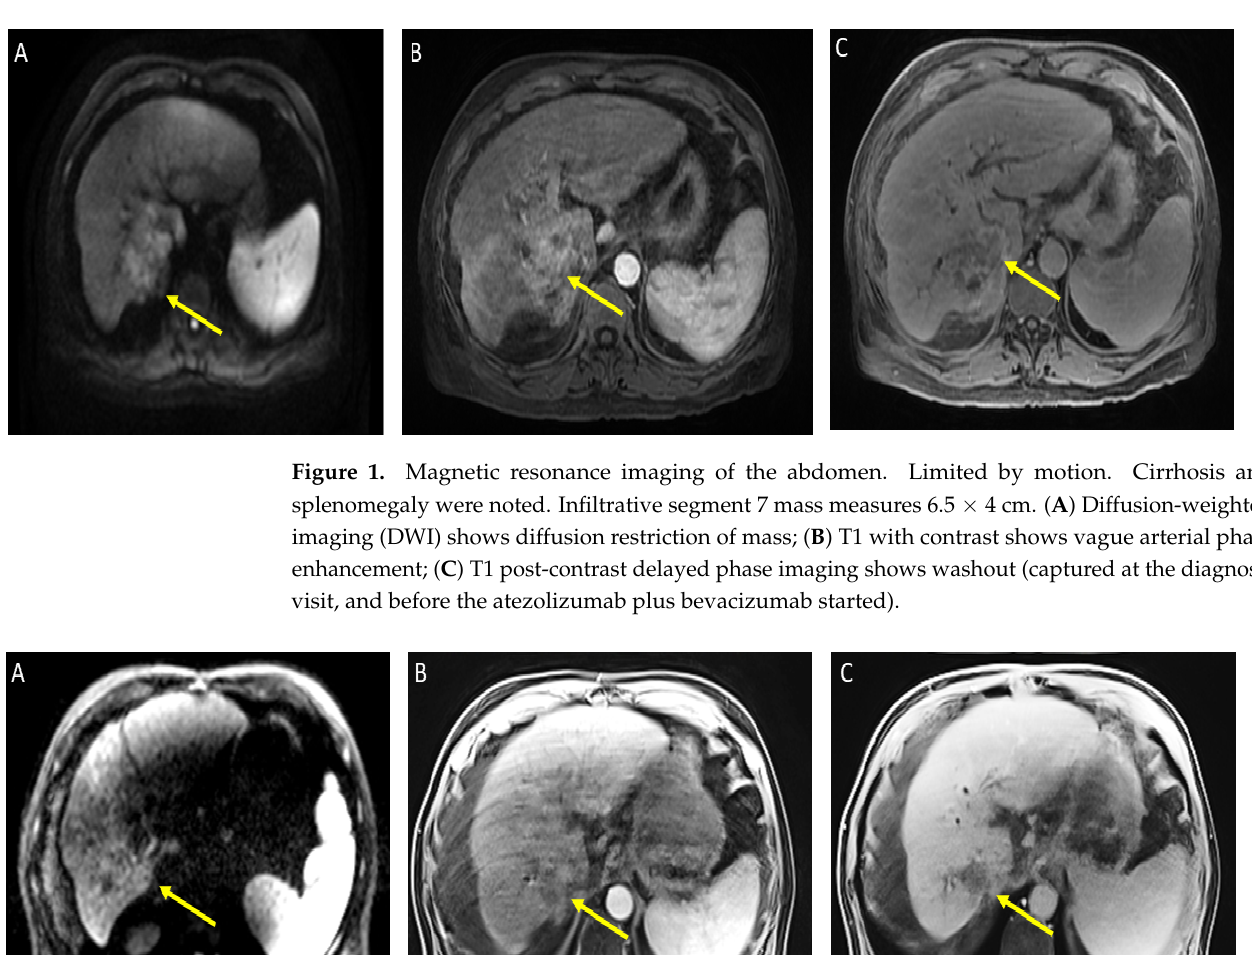
Figure 1. Magnetic resonance imaging of the abdomen. Limited by motion. Cirrhosis and spleno- megaly were noted. Infiltrative segment 7 mass measures 6.5 × 4 cm. ( A ) Diffusion-weighted imag- ing (DWI) shows diffusion restriction of mass; (B ) T1 with contrast shows vague arterial phase en- hancement; ( C ) T1 post-contrast delayed phase imaging shows washout (captured at the diagnosis visit, and before the atezolizumab plus bevacizumab started).